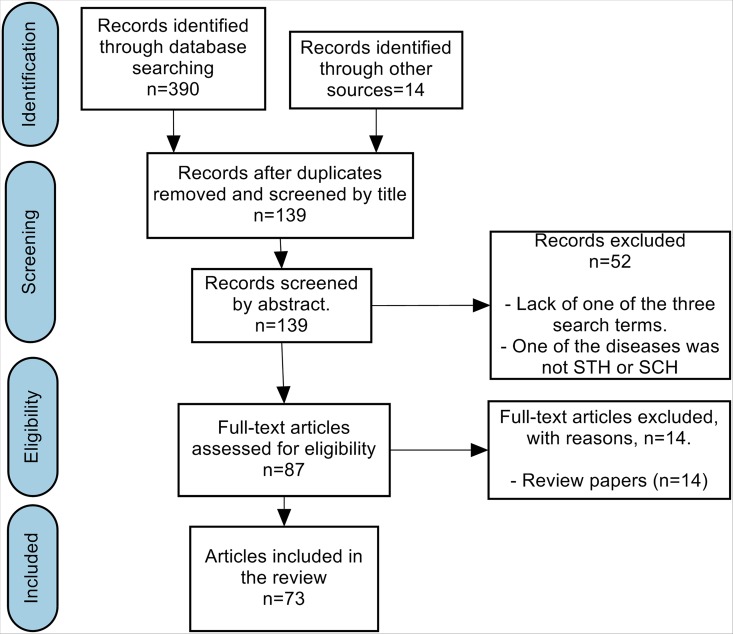
PRISMA flow diagram.